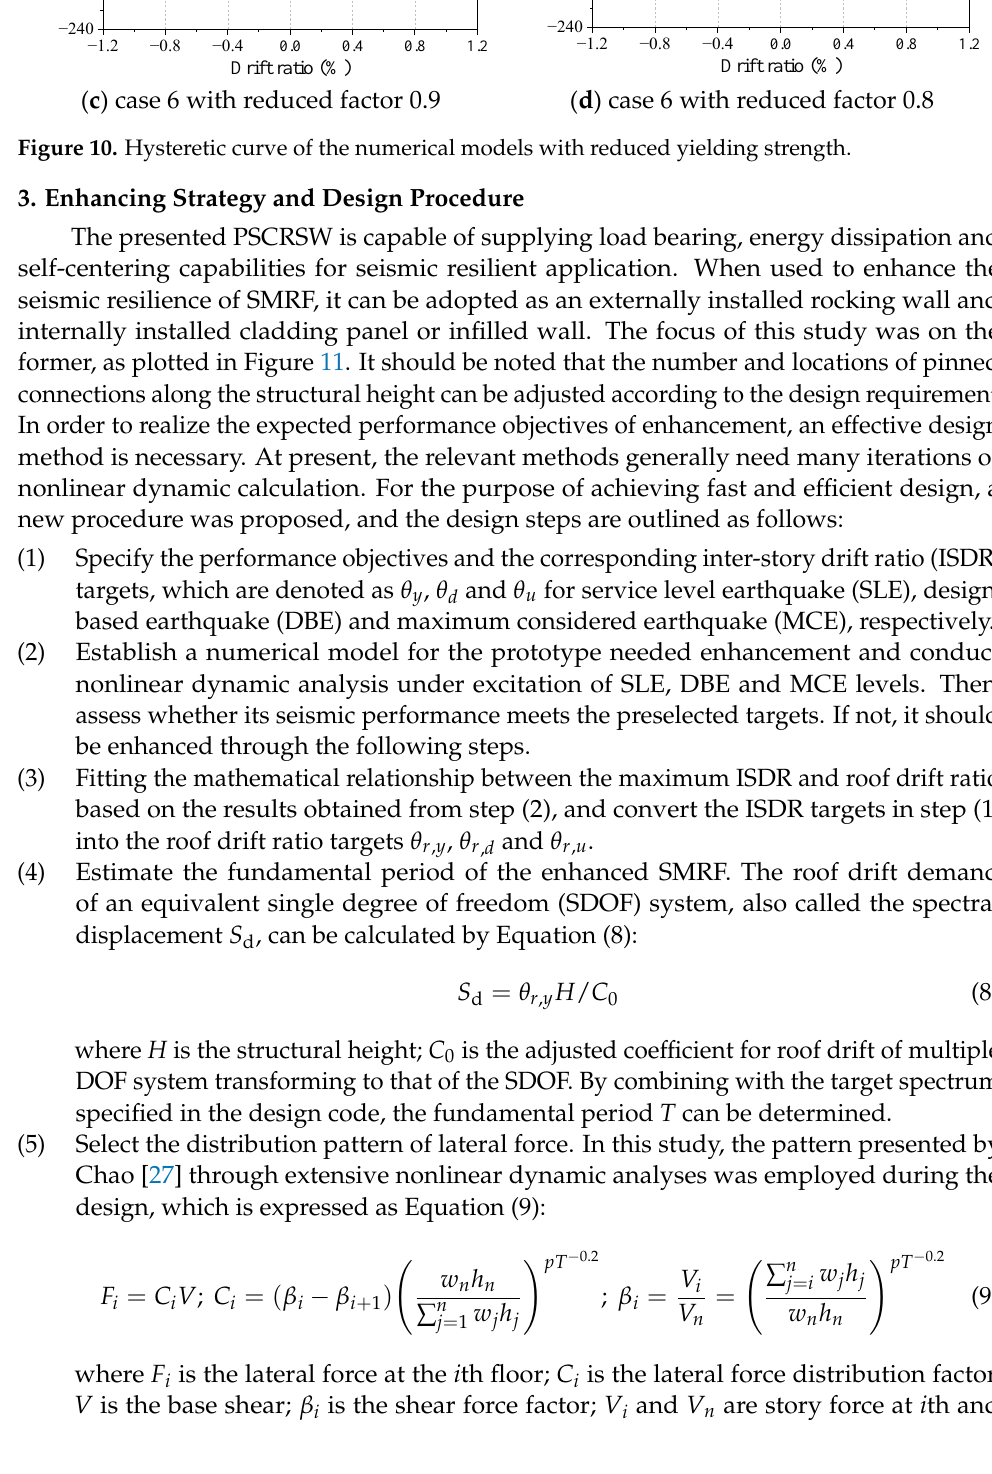
Figure 11. Enhancing strategy for SMRF.